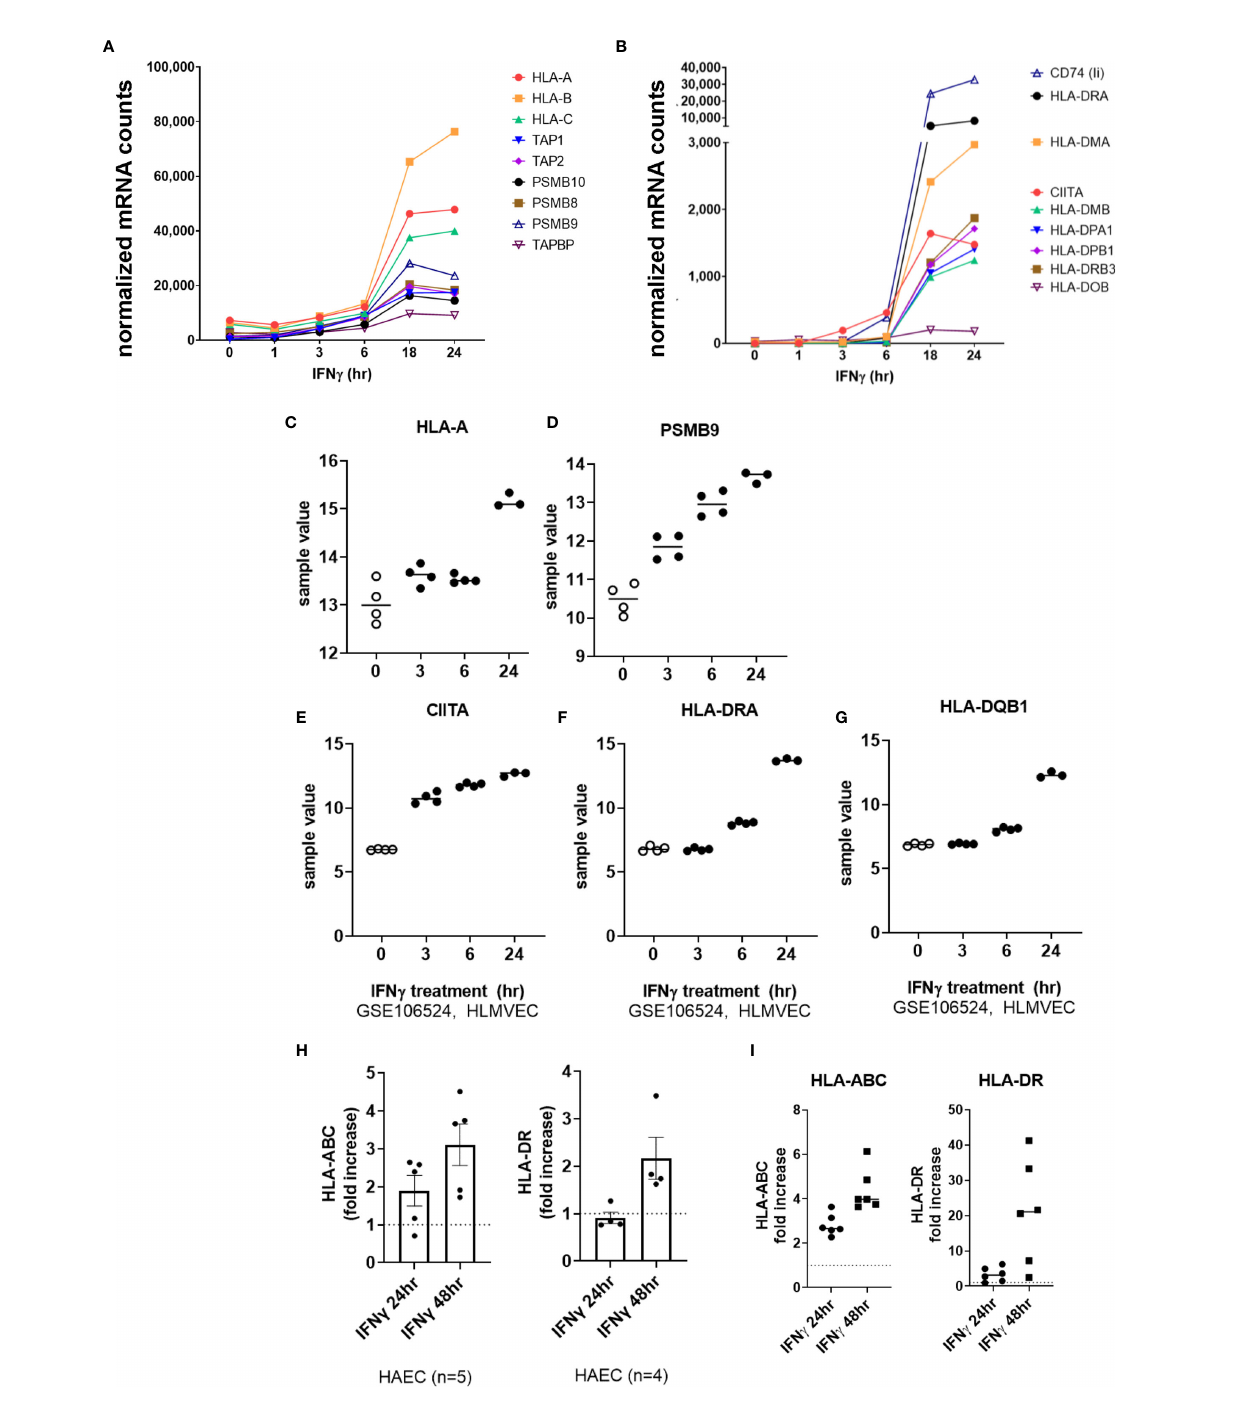
FIGURE 7 | IFN g induces late phase endothelial expression of HLA, immunoproteasome genes, and cytokines. (A, B) HMEC-1 endothelial cells were stimulated with TNF a (20ng/mL) for 1hr, 3hr, 6hr, 18hr or 24hr. Time course of IFN g induced transcripts in HMEC-1, for HLA class I (A) , and (B) HLA class II genes. One representative experiment is shown. Results are presented as absolute number of normalized mRNA counts for each gene, normalized to housekeeping controls. (C-G) Expression values of HLA-A (C) , PSMB9 (D) , CIITA (E) , HLA-DRA (F) and HLA-DQB1 (G) from GSE106524 are plotted. Human lung endothelial cells were stimulated with IFN g for 3hr, 6hr or 24hr (n=3-4). (H) Primary human aortic endothelial cells (n=4-5 donors) were treated with IFN g for 24hr or 48hr. Cell surface expression of HLA-ABC and HLA-DR was measured by fl ow cytometry (n=2). Results are presented as average fold increase in MFI of each molecule relative to untreated cells. (I) Primary human (HAEC, HCAEC, HCMVEC, HPAEC, HPMVEC, HLSEC) endothelial cells were treated with IFN g for 24hr or 48hr. Cell surface expression of HLA-ABC (left panel) and HLA-DR (right panel) was measured by fl ow cytometry